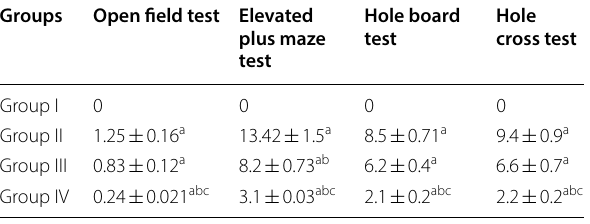
Table 3 Effect of E. hirta extract on the ambulation in open field test, elevated plus maze, hole board and cross